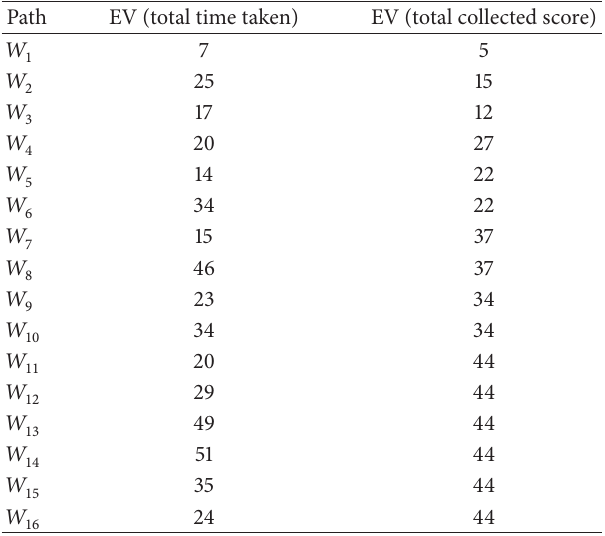
Table 4: The expected value of the total time taken to traverse the path and the total collected score for each of the paths. Path EV (total time